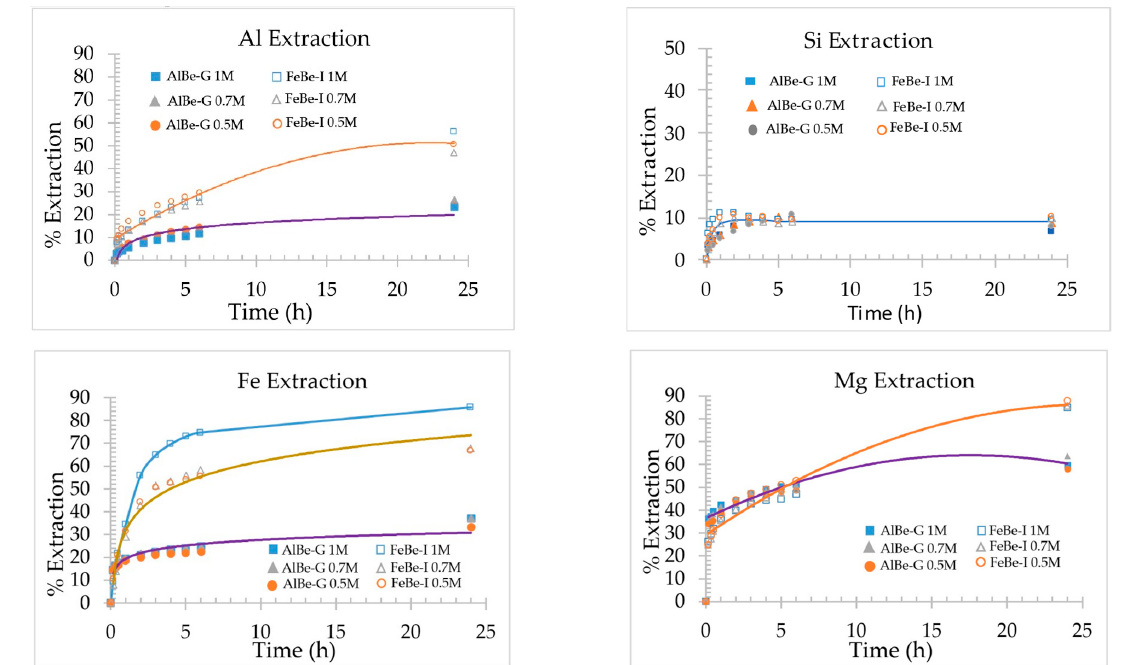
Figure 3. Extraction of metals versus time for AlBe-G and FeBe-I samples in oxalic acid (80 °C; acid concentrations of 0.5 M, 0.7 M and 1 M; 2% of pulp density).